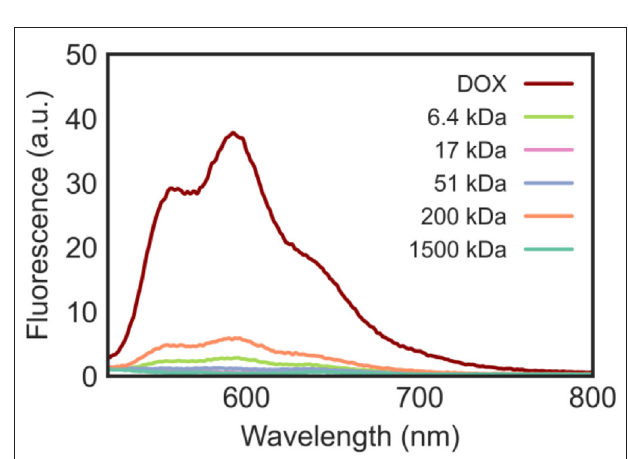
FIGURE 6 | Emission spectra in water at λ ex 480 nm of DOX (10 µ g/mL) and DOX/CNT/HA-DMPE (20 µ g/mL) at various HA chain lengths (6.4, 17, 51, 200, and 1,500